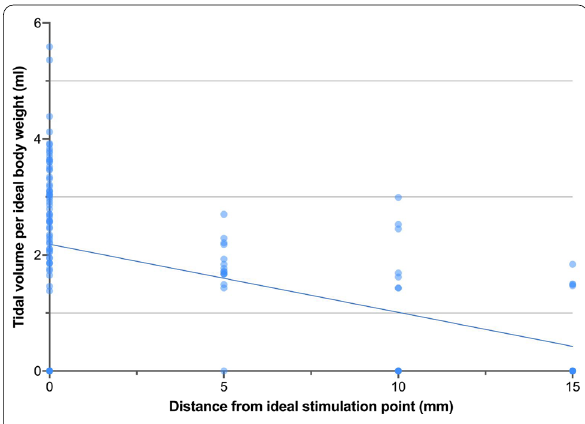
Figure 1 Tidal volume depends on medio-laterally distance to the ideal stimulation site. Conclusion: The effectiveness of non-invasive electromagnetic phrenic nerve stimulation declines linearly with increasing medio-lat- erally distance to the ideal stimulation site, which therefore should be determined prior to any